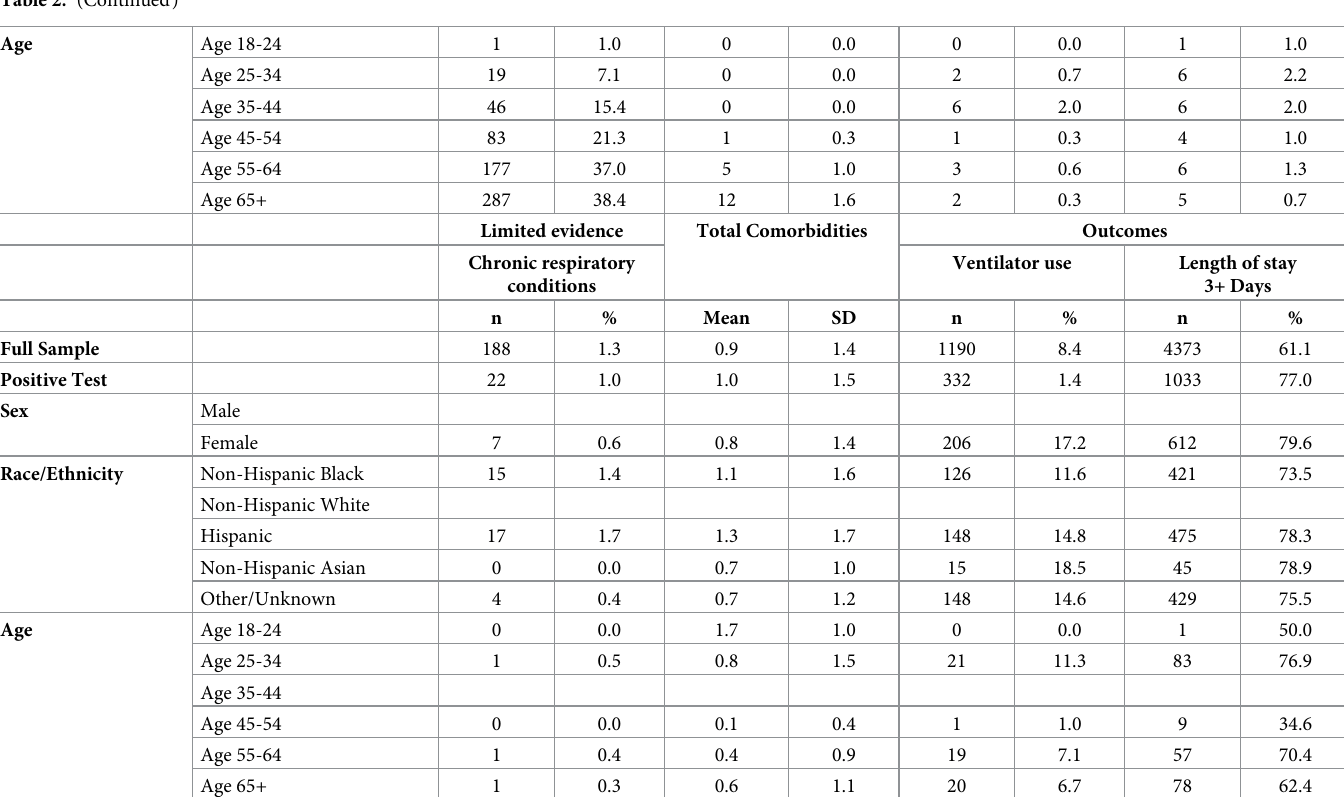
White (0.7), and Hispanic (0.7) patients. Compared to positive patients of all other age groups, positive patients 65+ had higher rates of: CKD, COPD, cardiovascular disease, type 2 diabetes, hypertension, cerebrovascular disease, and chronic respiratory conditions. The 65+ age group also had a higher mean (1.3) total comorbidities compared to positive patients of other age groups.